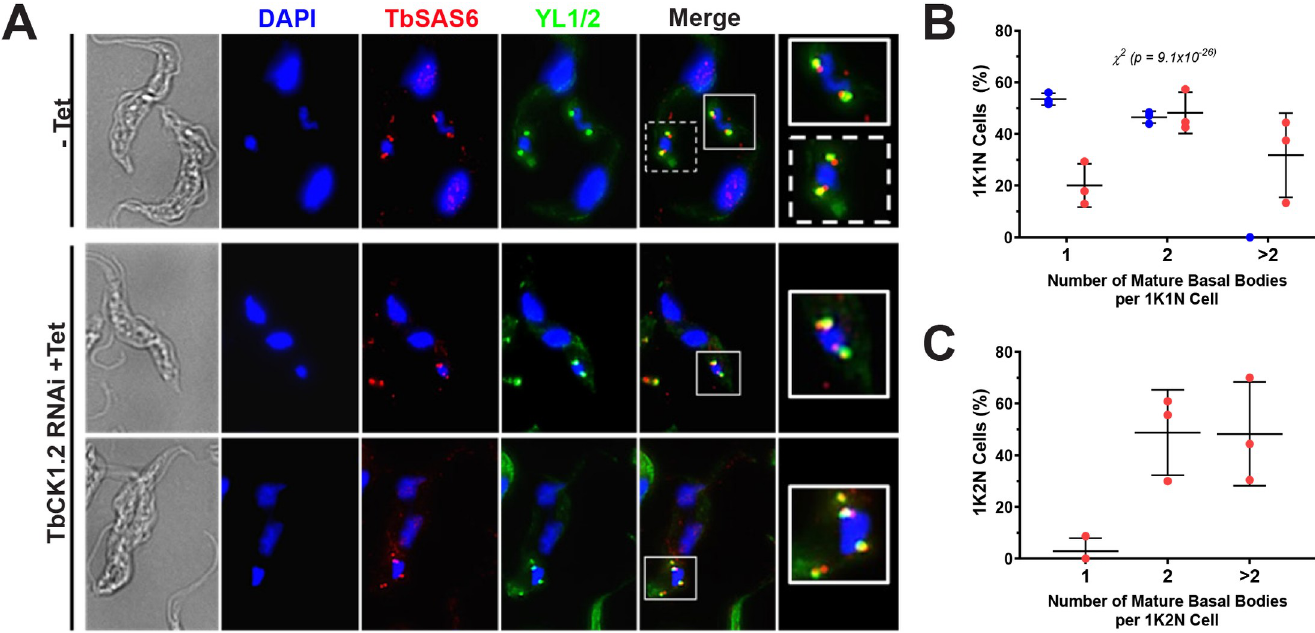
Fig 3. Basal bodies are duplicated after knockdown of TbCK1.2. Knockdown of TbCK1.2 was induced with tetracycline (1 μ g/mL for 24 h) and the effect on basal body duplication was determined using antibodies against TbRP2 (YL1/2, mature basal bodies) or TbSAS6 (detects mature and probasal bodies). DAPI was used to stain DNA. (A) Images represent 1K1N trypanosomes from control cells (-Tet) or 1K2N cells from TbCK1.2-depleted cells (+Tet) with two (2BB) or more ( > 2BB) basal bodies. Boxed regions are enlarged in the final panel. The average percentage of cell types with the indicated number of mature basal bodies (mBB, YL1/2+) is shown for 1K1N (B) or 1K2N trypanosomes (C) from three independent experiments (n = 108-128/experiment). Blue and red symbols indicate control and RNAi treated samples, respectively. Error bars denote standard deviation. The distribution of mBBs in 1K1N trypanosomes after knockdown of TbCK1.2 was compared to control cells (-Tet) using a χ 2 test (1K1N p = 9.1 x 10 − 26 ). (A χ 2 test could not performed for the 1K2N population because those cells were undetectable ( < 1%) in the uninduced